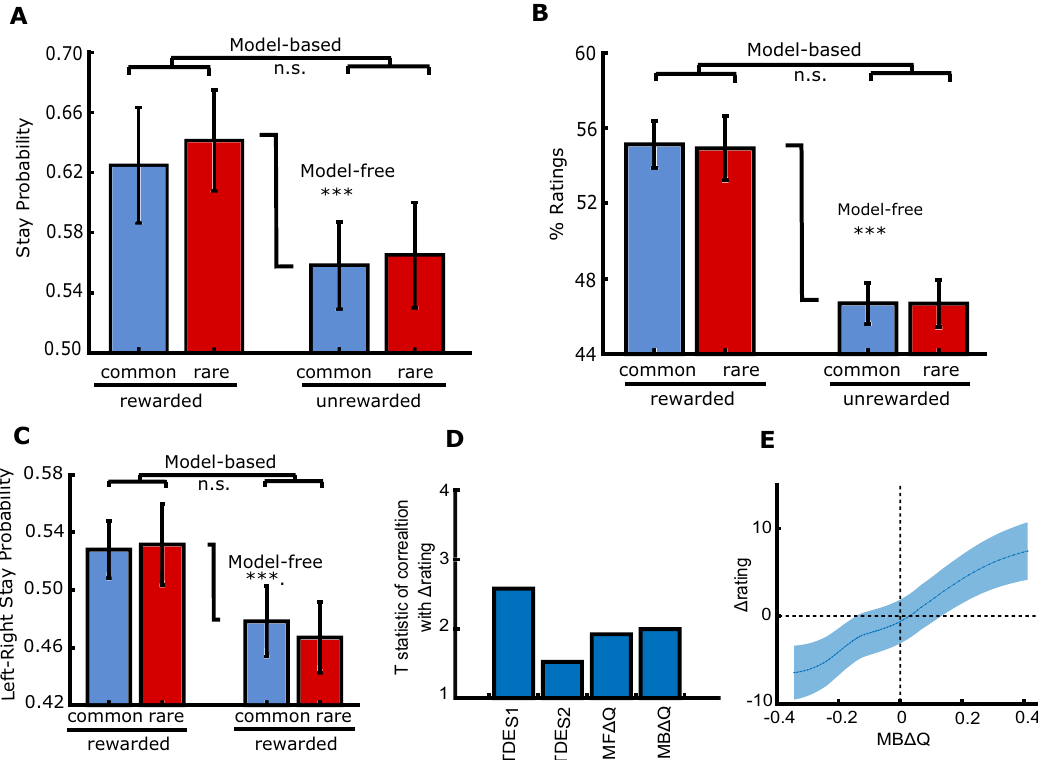
Figure 4. Subjects without explicit instructions showed model-free choice and model-free influences in rating. ( A ) Contributions of model-free and model-based learning to stay probability. Error bars throughout represent within-subject standard error of the mean. ( B ) Contributions of model-free and model-based learning to value ratings of stage-one shapes. % Ratings indicate the average percentile of ratings. ( C ) Participants were more likely to return to the same side of the screen (left or right) in their stage 1 choices if they received a reward. ( D ) t-statistic indicating how well the change in rating was predicted by each of the four RPEs. ( E ) The subjective ratings were changed by intervening trials’ MBΔQ. Trials were binned according to quantiles of the prediction error, line indicates mean, shaded area indicates standard error of the mean across participants. n.s. not significant, *p < 0.05, **p < 0.01, ***p <